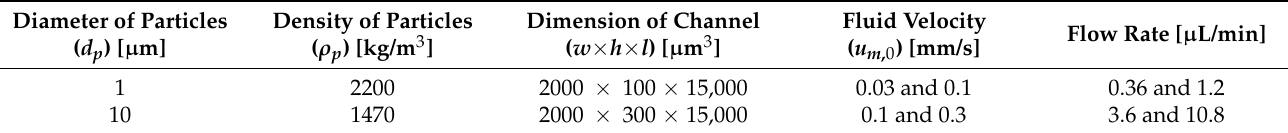
Table 1. The values of the parameter used for the experimental test.